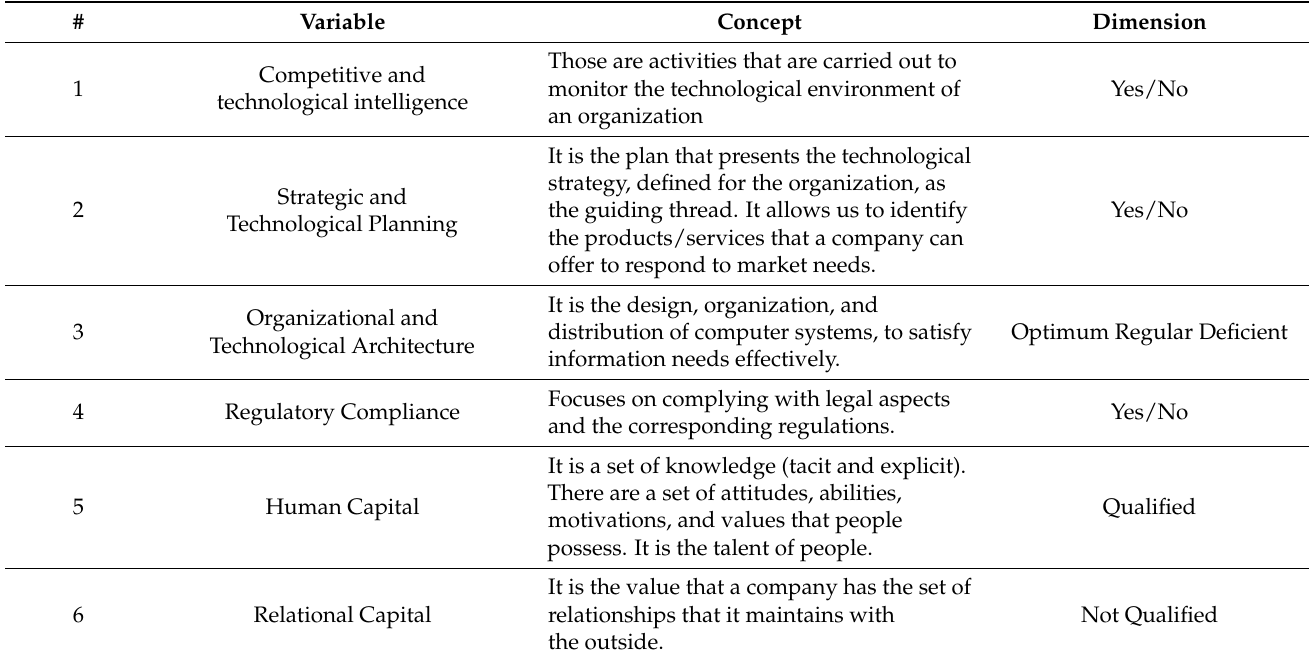
Table 2. Definition of the variables and nodes.